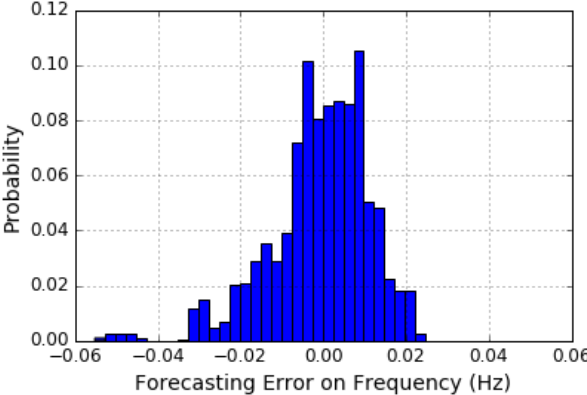
Figure 13. Distribution of f